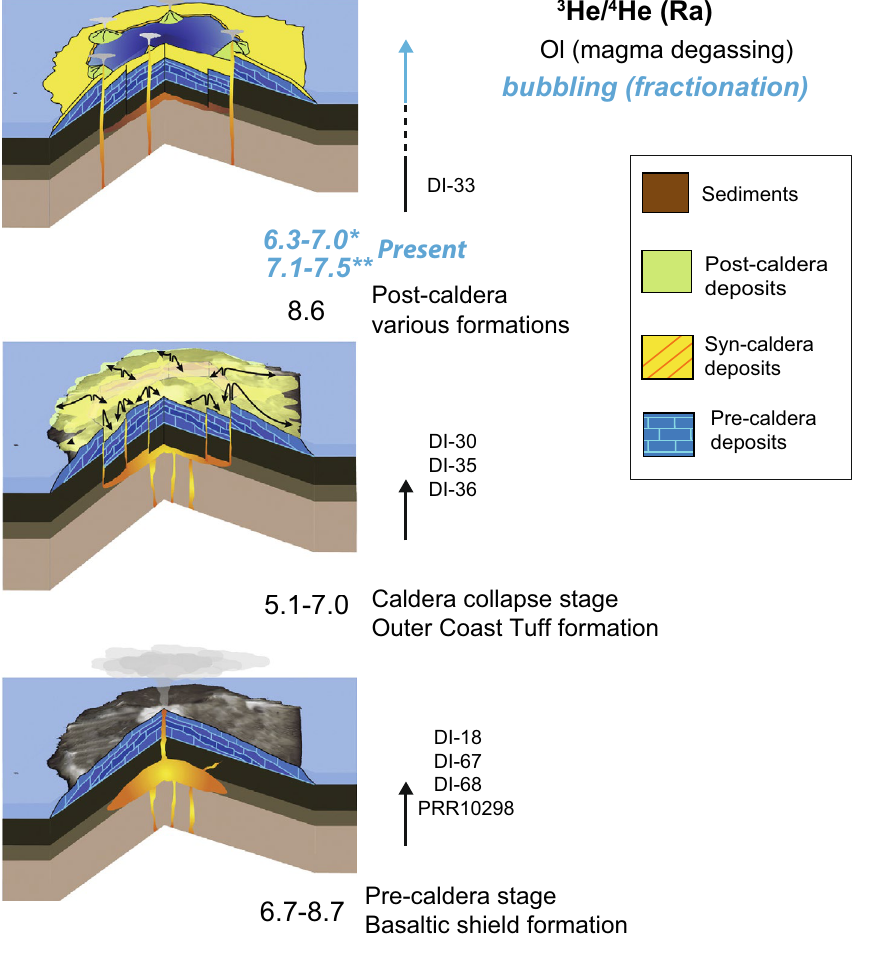
Figure 3. Summary-sketch evolution of the He isotopic ratios along the volcanic history of Deception Island (3D blocks are modified from 17 ) (*: Kusakabe et al. 13 ; **: Padrón et al. 40 ). This figure was generated with